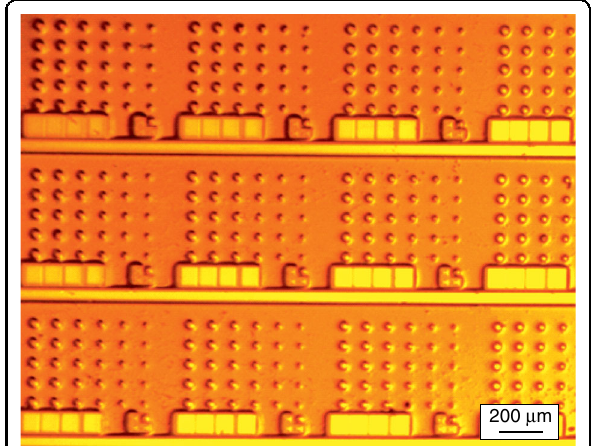
Fig. 5 Arrays of microdisks. 6 × 5 arrays of QD-on-Si microdisks of different diameters (11, 15 … 31 μ m) with gold-plated buffer layer between mesas